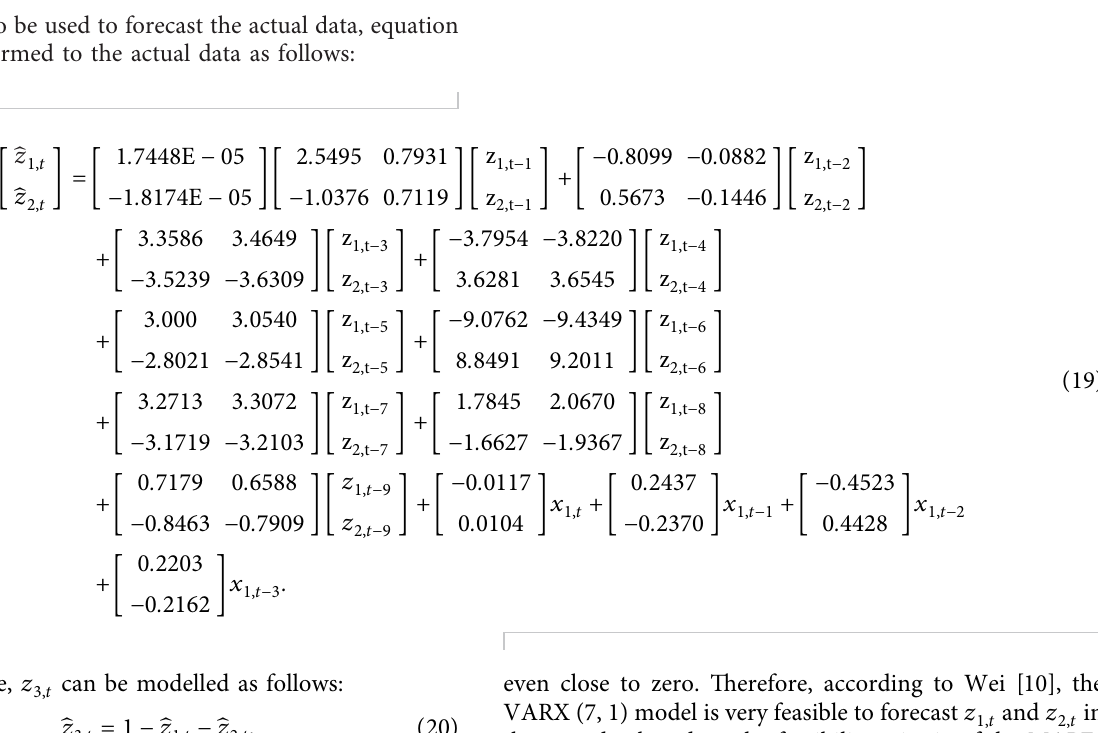
Table 3: Te correlation rates between endogenous and exogenous variables. Data pairs Te correlation rates